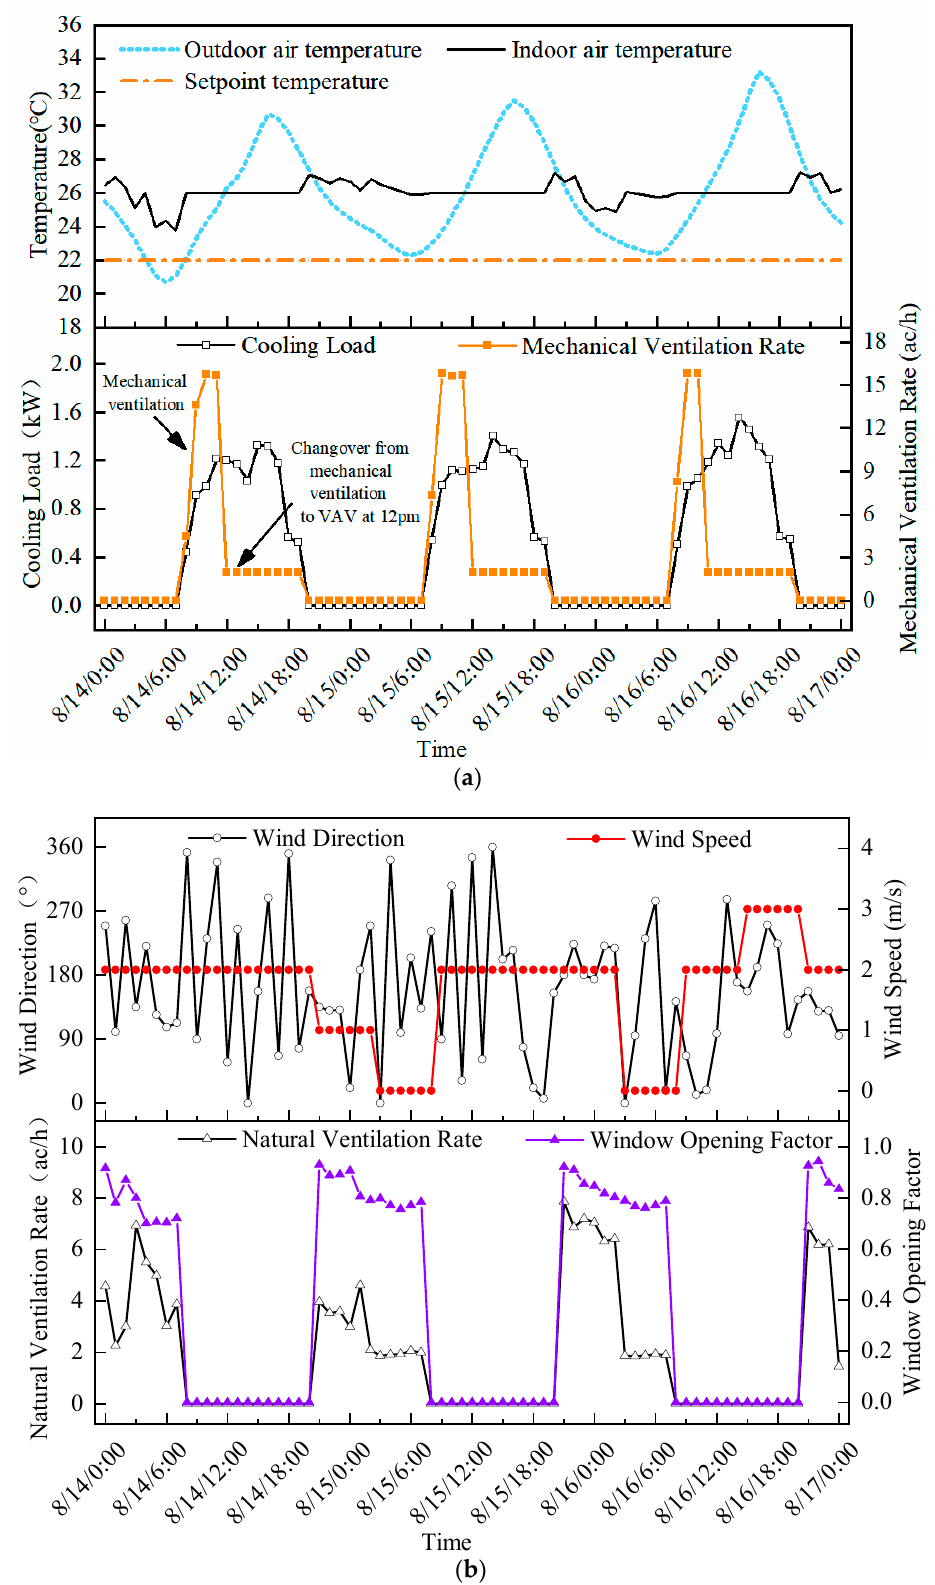
Figure 12. ( a ) Predicted space temperatures, cooling load and ( b ) airflow rates during 3 days in August (mixed-mode cooling).